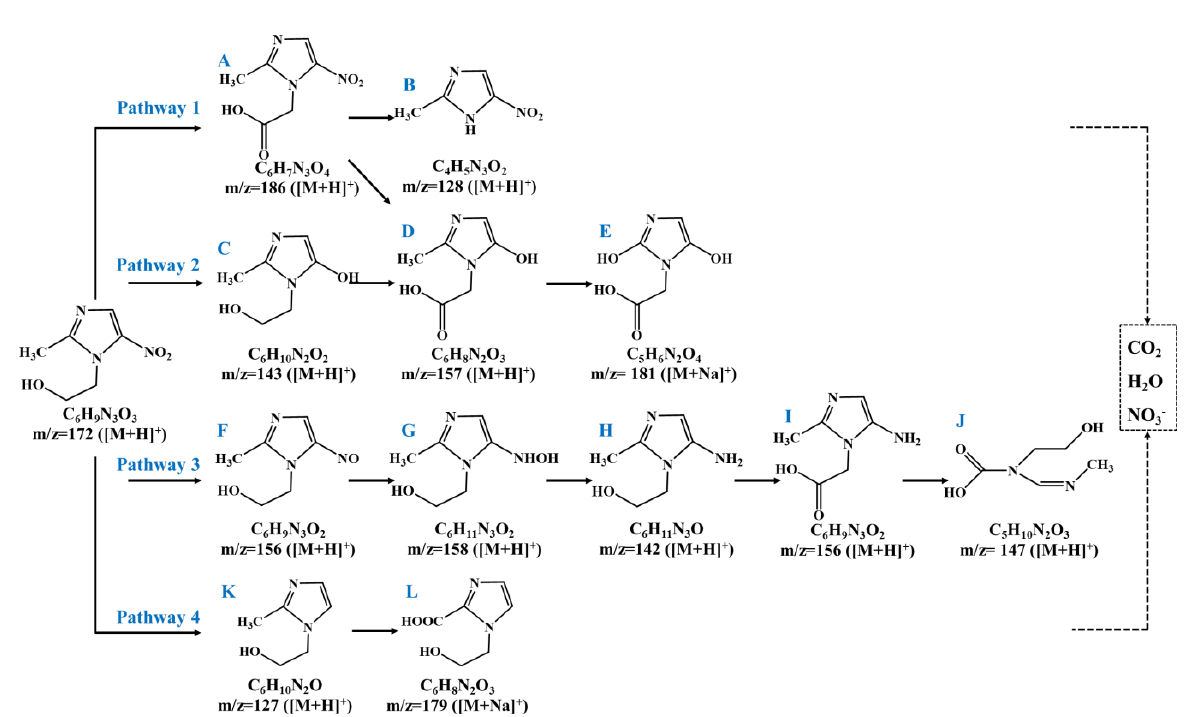
Figure 10. Possible degradation pathways of metronidazole: ( A – L ) intermediate products of met-